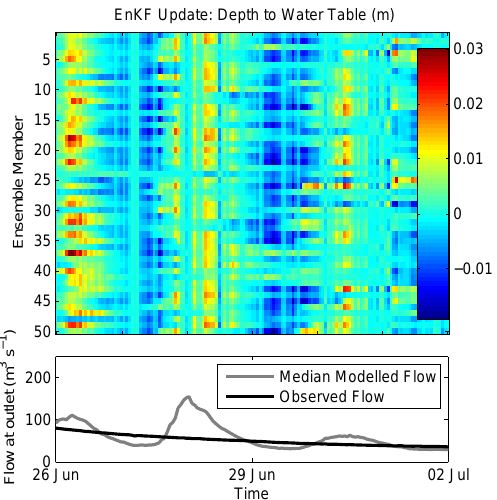
Fig. 16. Updates to depth to water table for each ensemble member for a sample reach in the Motueka. Modelled and measured flow are shown for comparison. Lags between updates and flow response cause oscillations during this